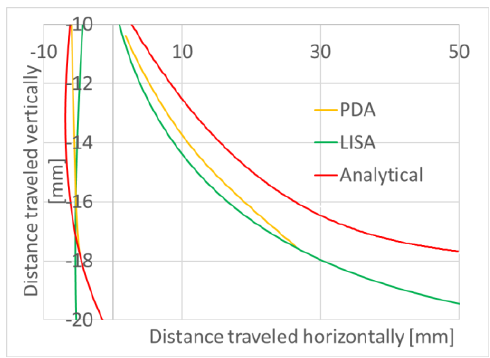
Fig. 13 Comparison of droplet trajectories (40 – 80µm) from leeward and windward sides in cross-flow velocity of 16 m/s for the analytical model, LISA and experimental streamlines created from PDA data